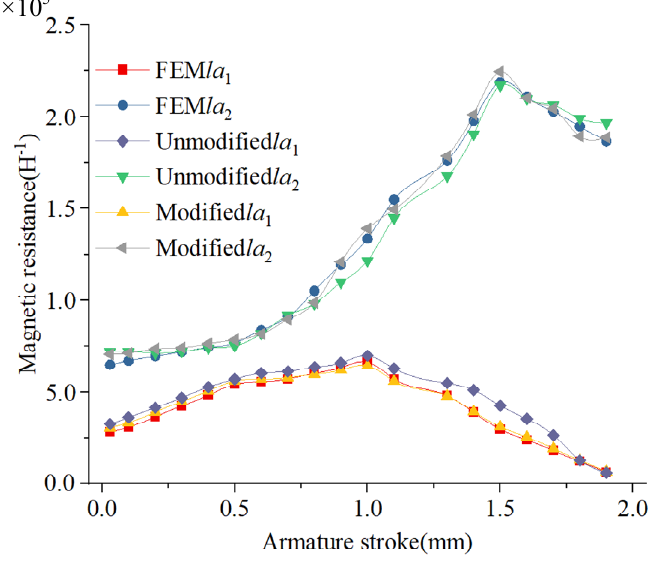
Figure 9. The soft magnetic resistance of FEM and unmodified and modified DPM. The modified MFL permeance and soft magnetic resistance data are substituted into the DPM. The FEM results are compared with the modified and unmodified DPM results of the force on the armature for a coil excitation of 1800 AT and −1800 AT, as shown in Figure 10. The unmodified DPM mean error is 10.2%, and the modified DPM mean error is 3.8%. The FEM and measurement results mean error is 3%.